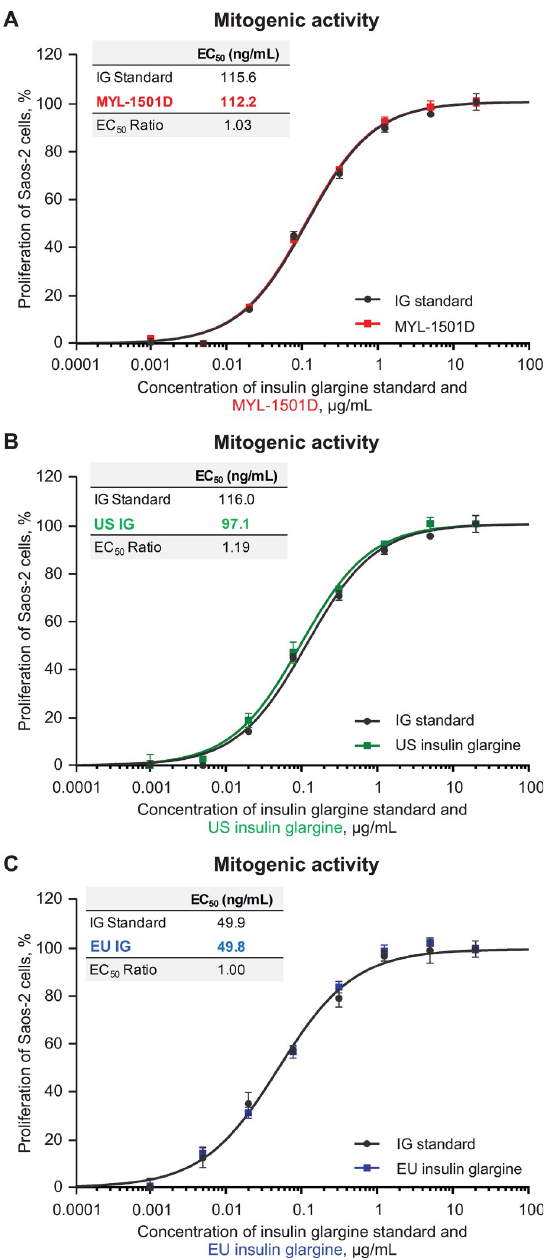
Fig 16. Representative dose-response curves of mitogenic assay in Saos-2 cells. (A) MYL-1501D, (B) US-Licensed Insulin Glargine, and (C) EU-Licensed Insulin Glargine. All samples were analyzed against a common insulin glargine reference standard (IG standard) to normalize against day-to-day variability. Each lot was analyzed using 3 independent dilution preparations on an assay plate. Mean ± SEM for the % proliferation is plotted (y-axis) against the concentration (x-axis). Four parameter logistic curve fit was applied to evaluate EC 50 . Each sample was analyzed on 3 independent assay plates, and average is reported. EC 50 , half maximal effective concentration; Saos-2, sarcoma osteogenic